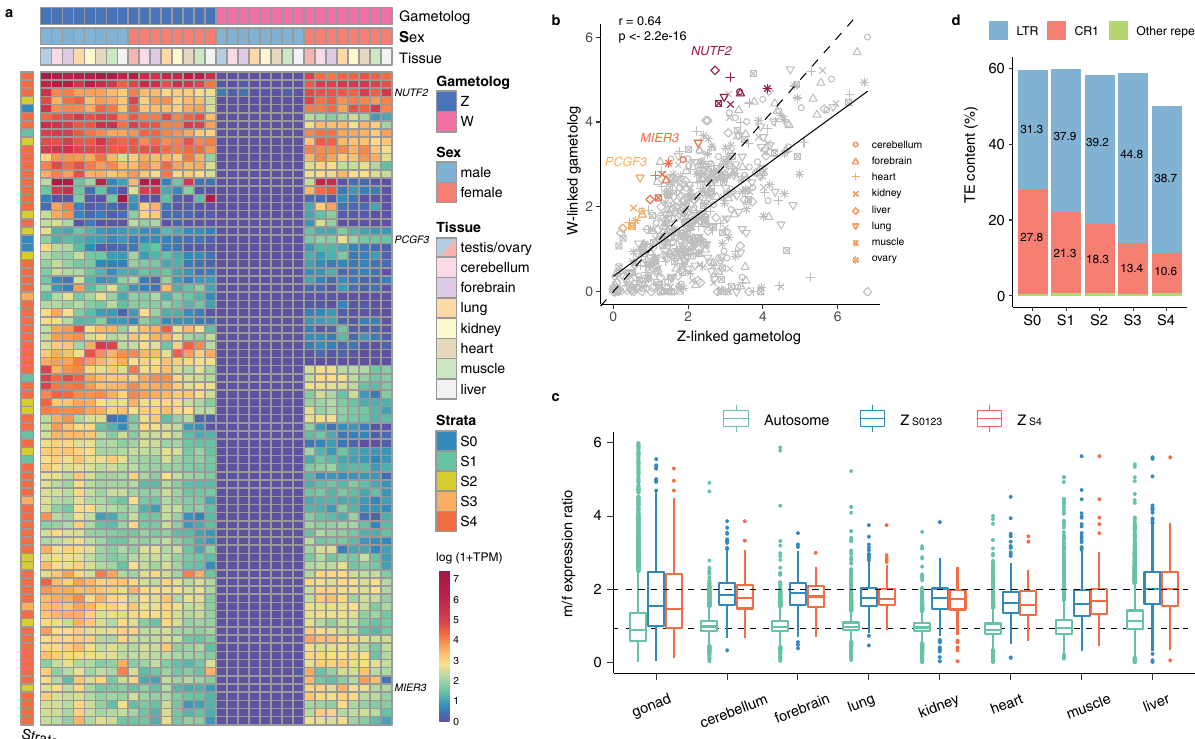
Fig. 4 Non-adaptive evolution of the neo-sex chromosome. a A heatmap showing the expression (measured by log (1 + TPM)) of Z-W gene pairs across male and female tissues in monk parakeet. Each row represents one gene. The top three panels annotate whether a gene is Z- or W-linked and in which tissue/sex it is expressed. The left panel annotates which stratum a gene belongs to. The W-linked gametologs are present only in females (purple in male), but their expression pro fi les are similar to their Z-linked homologs. b The X - and Y -axis show the expression of Z- and W-linked gametologs, respectively. The solid line represents the regression relation between the expression of the Z and W, while the dashed line indicates the situation of equal Z-W expression. c Male/female expression for Z-linked genes on the both old ( n = 529) and new ( n = 122) sex chromosomes, as well as autosomal genes ( n = 7,562). The boxplots show the fi rst quartile, median, and third quartile values. d Temporal dynamics of TE content on the monk parakeet W chromosome divided into fi ve evolutionary strata. LTRs are more abundant in younger